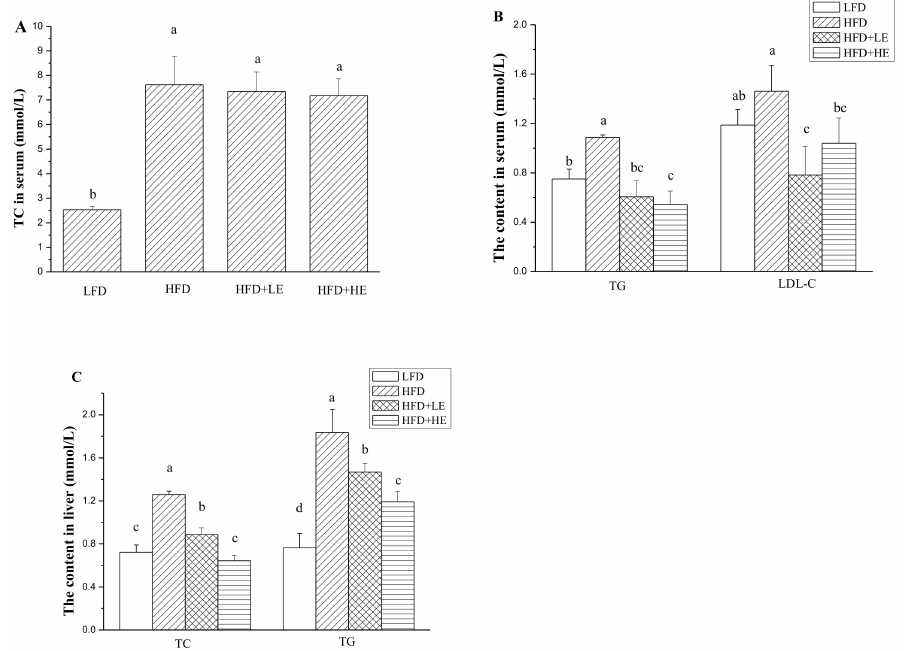
Figure 2. Effects of SCPE on the contents of TC in serum ( A ), TG and LDL-C in serum ( B ), TC and TG in liver ( C ). Different lower-case letters correspond to significant differences at p <